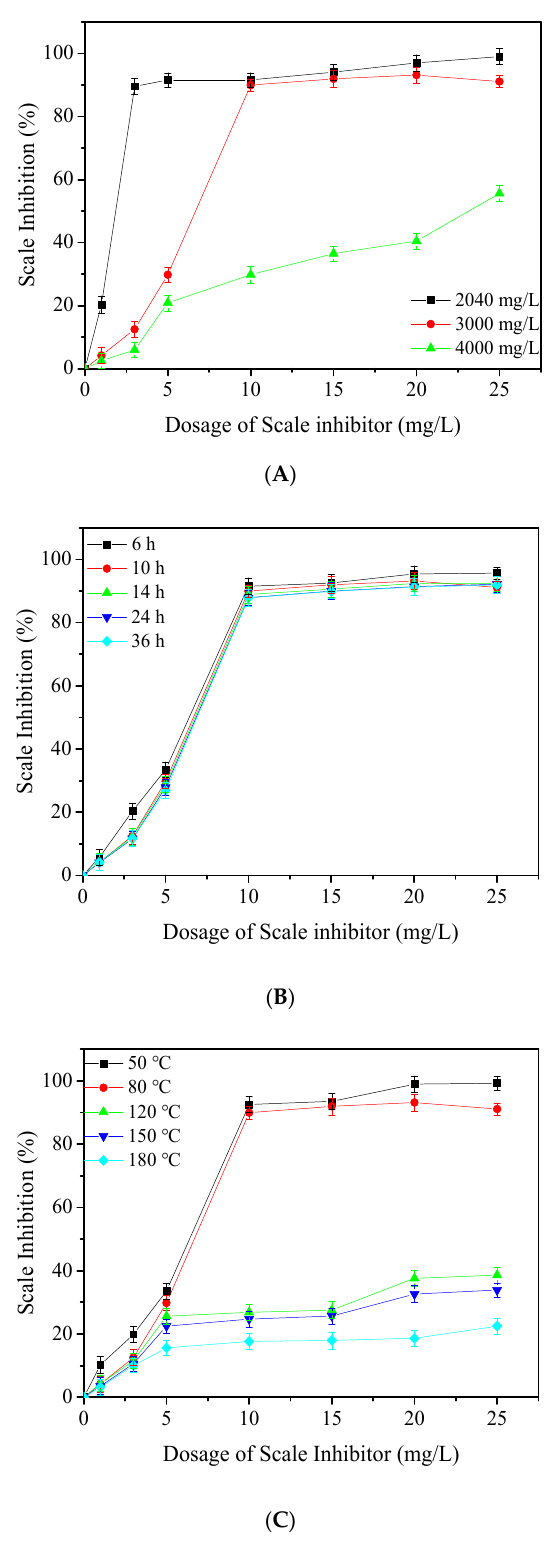
Figure 5. Precipitation inhibition performances of PEDTA-DEA on calcium sulfate under di ff erent initial calcium ion concentrations ( A ), (in which bath time is 10 h and temperature is 80 ◦ C), di ff erent water bath time ( B ), (in which initial calcium ion concentration is 3000 mg / L and temperature is 80 ◦ C), di ff erent water bath temperature ( C ), (in which initial calcium ion concentration is 3000 mg / L and bath time is 10